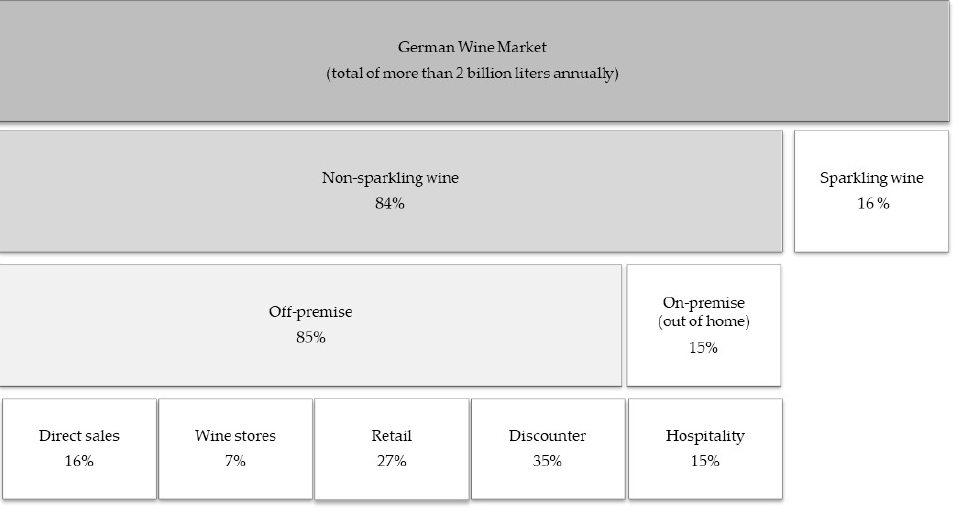
Figure 9. Wine market distribution: reaching consumers [55,72,160,174,180–181].